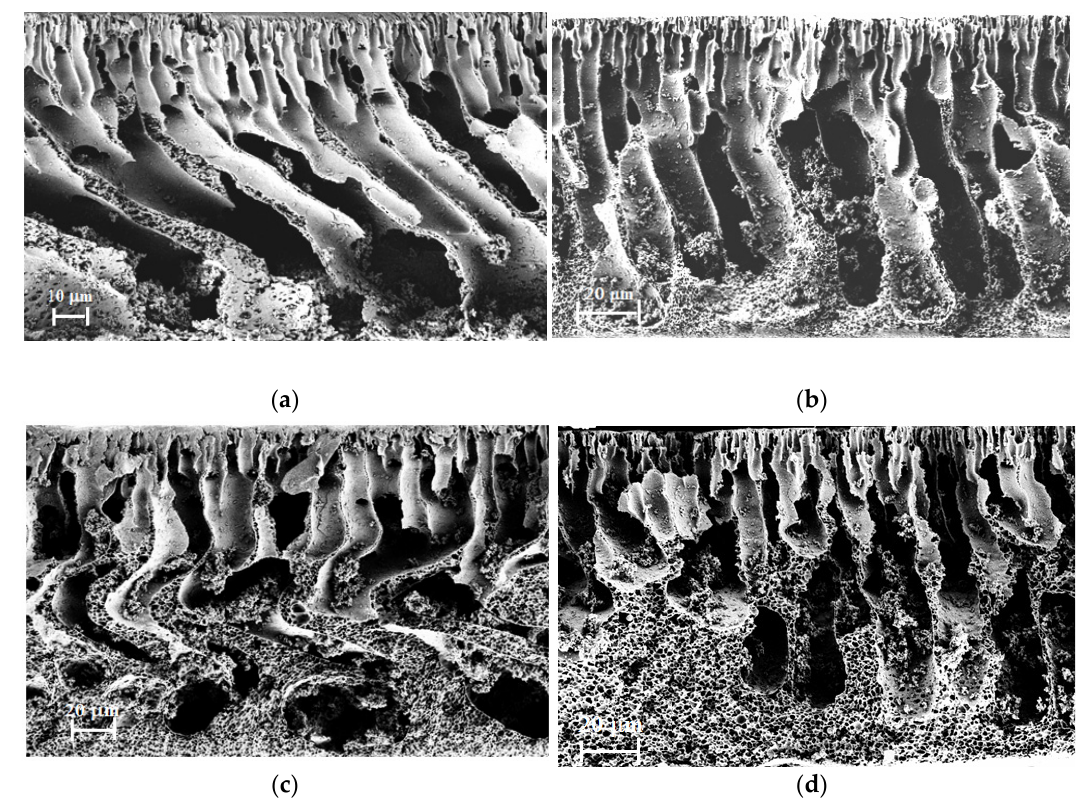
Figure 6. SEM micrographs of cross sections of the ( a ) PAI-0, ( b ) PAI-5, ( c ) PAI-10, and ( d ) PAI-15 membranes.